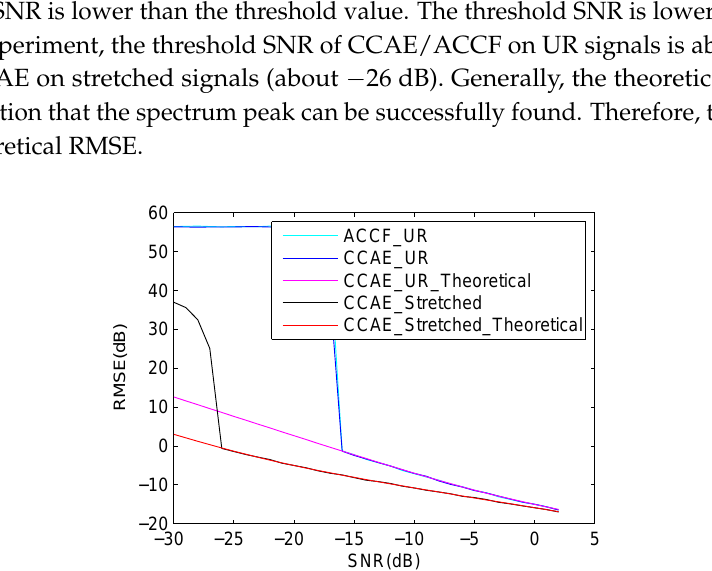
Figure 6. RMSE comparison of velocity estimation by using CCAE on stretched signals, CCAE on uncompressed received (UR) signals and adjacent cross-correlation function (ACCF) on UR signals (without